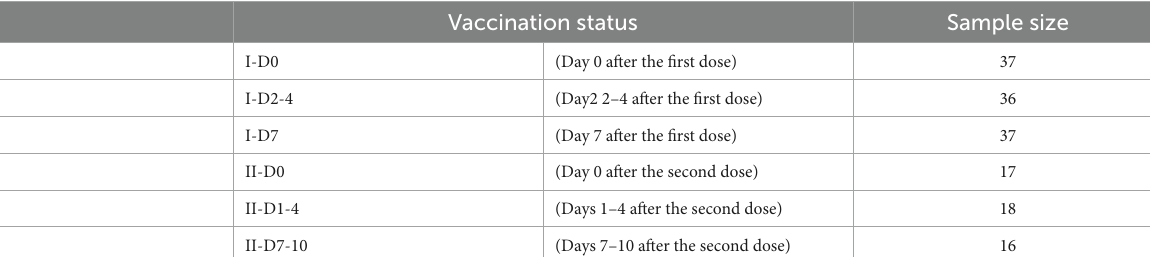
TABLE 1 Sample sizes of six vaccination